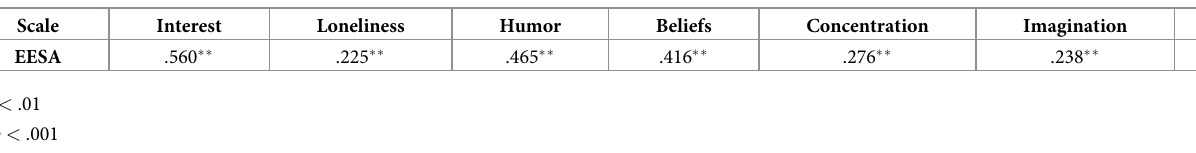
Table 5. Pearson’s correlations between the full scale (GSAM) and its factors with the EESA.